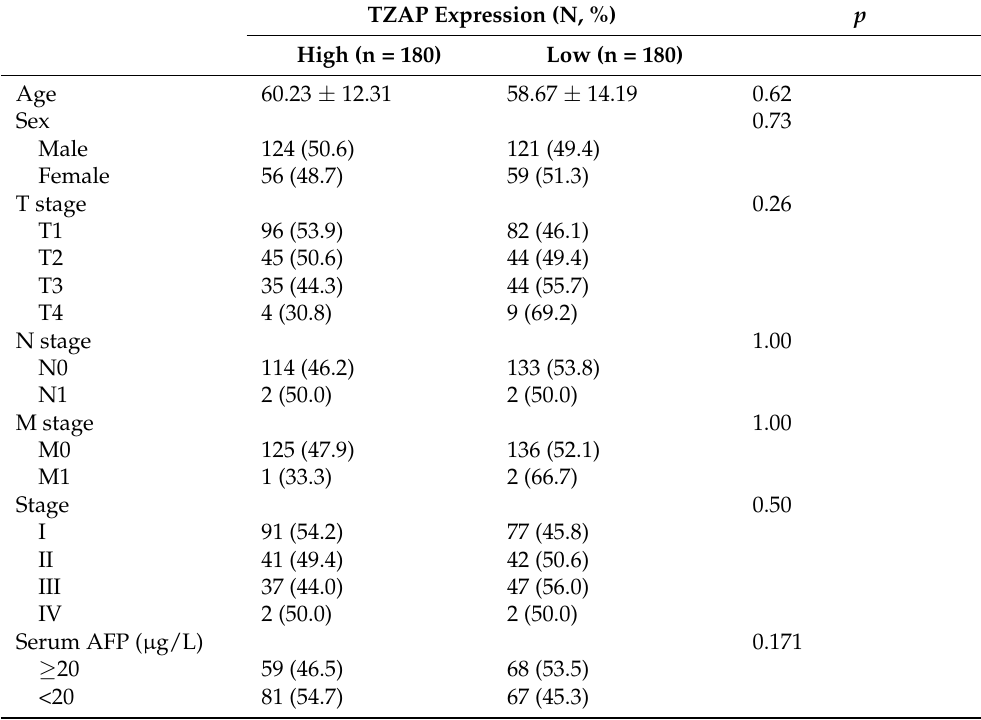
Table 2. TCGA data on TZAP expression in